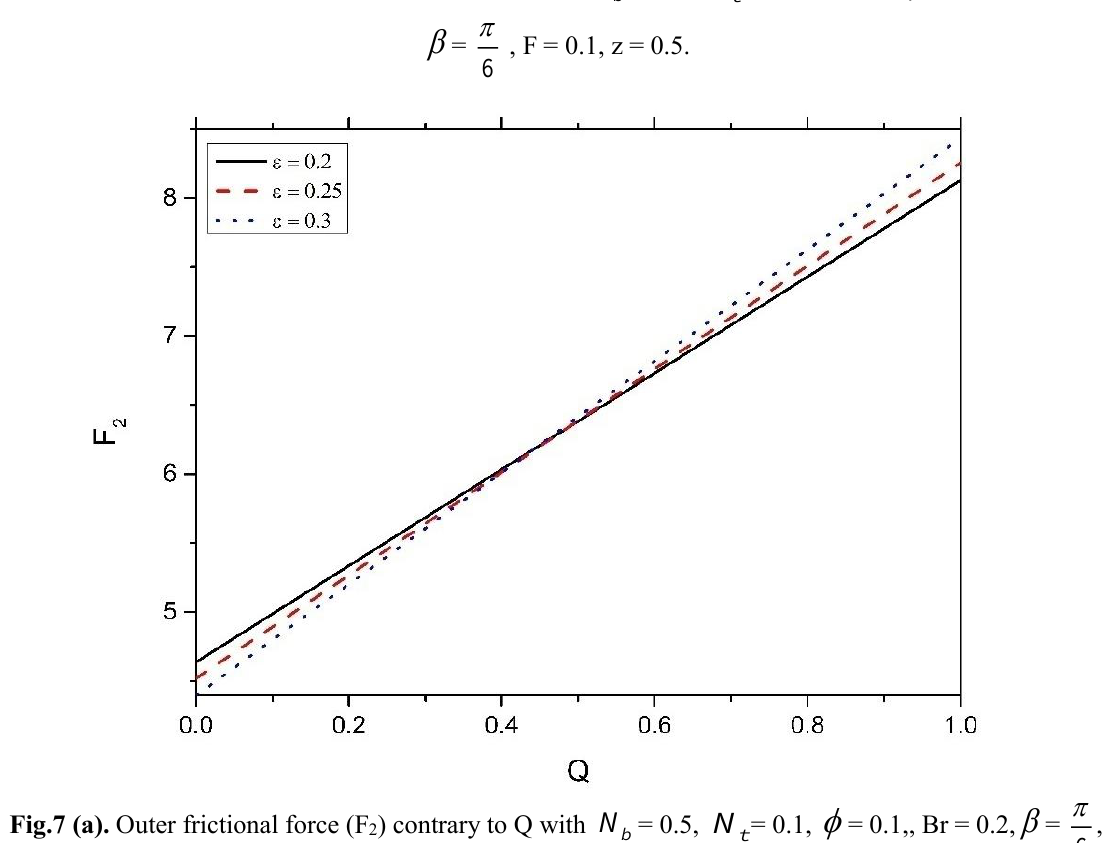
Fig. 6(e). Inner frictional force (F 1 ) contrary to Q with